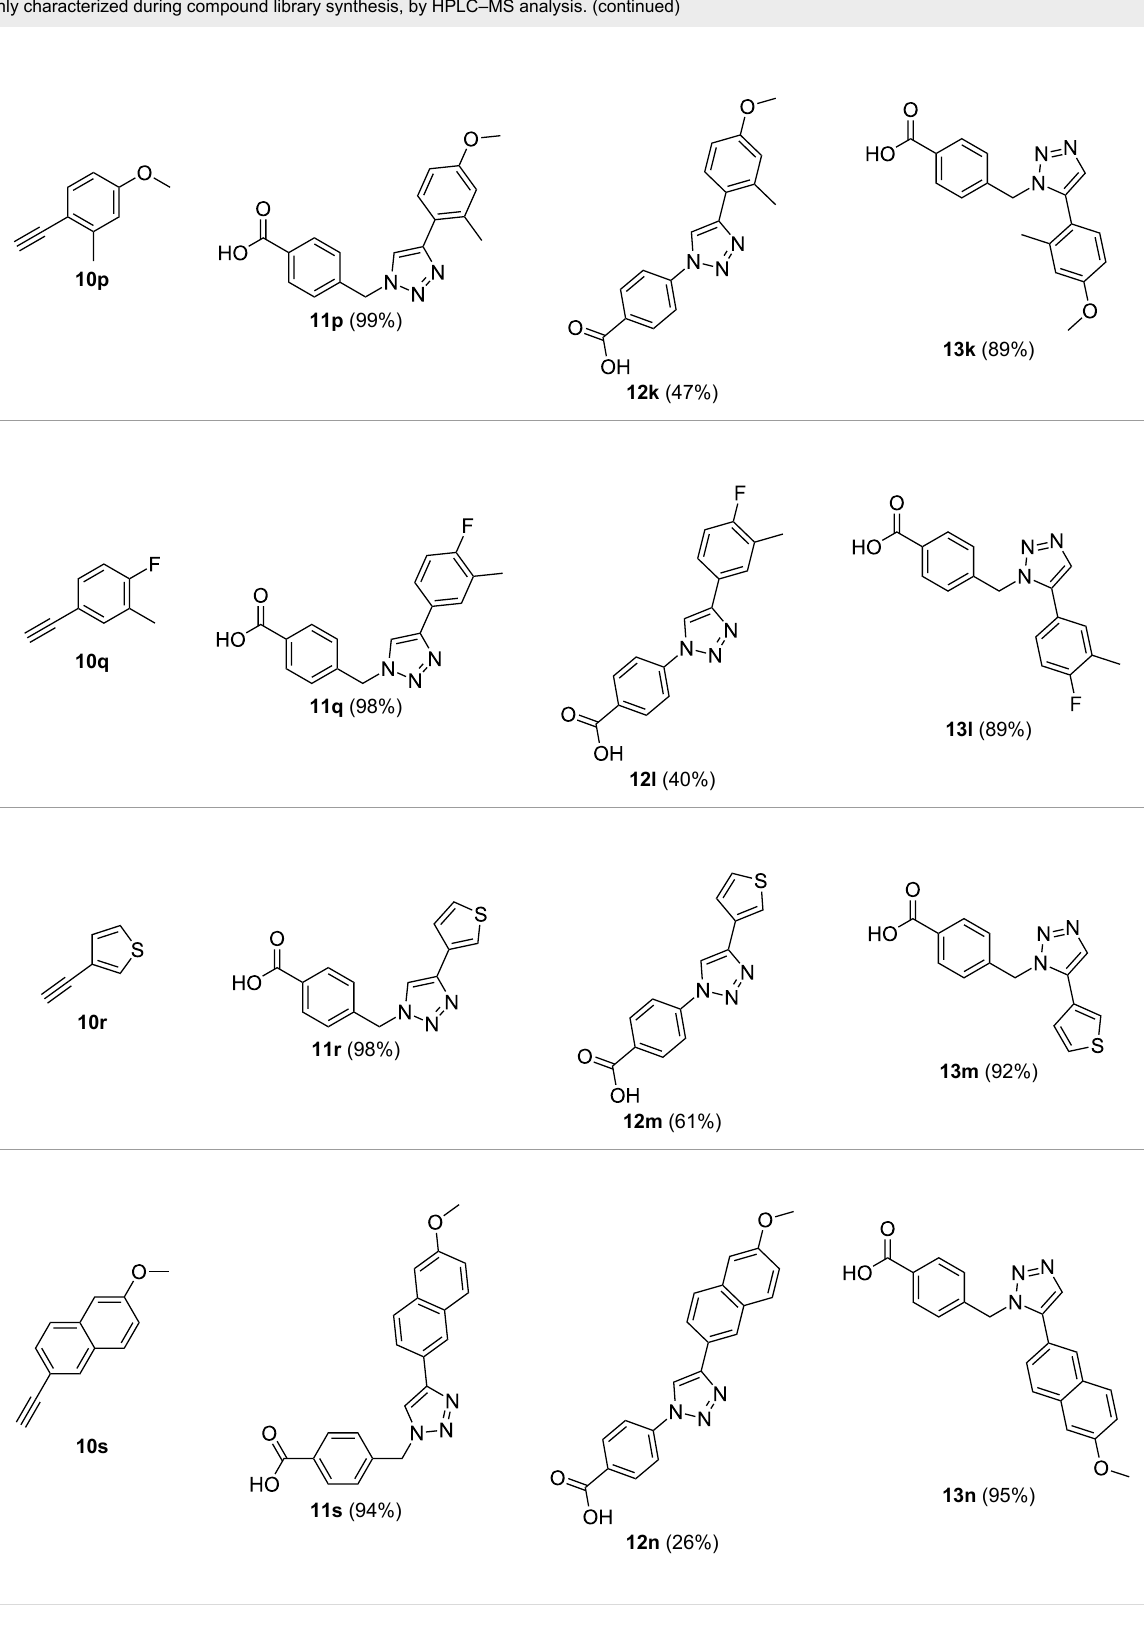
Table 2: Copper-catalyzed [2 + 3] cycloadditions of resin bound azide 7 with five terminal alkynes. Compounds 13 , with the exception of 13f , were only characterized during compound library synthesis, by HPLC–MS analysis.